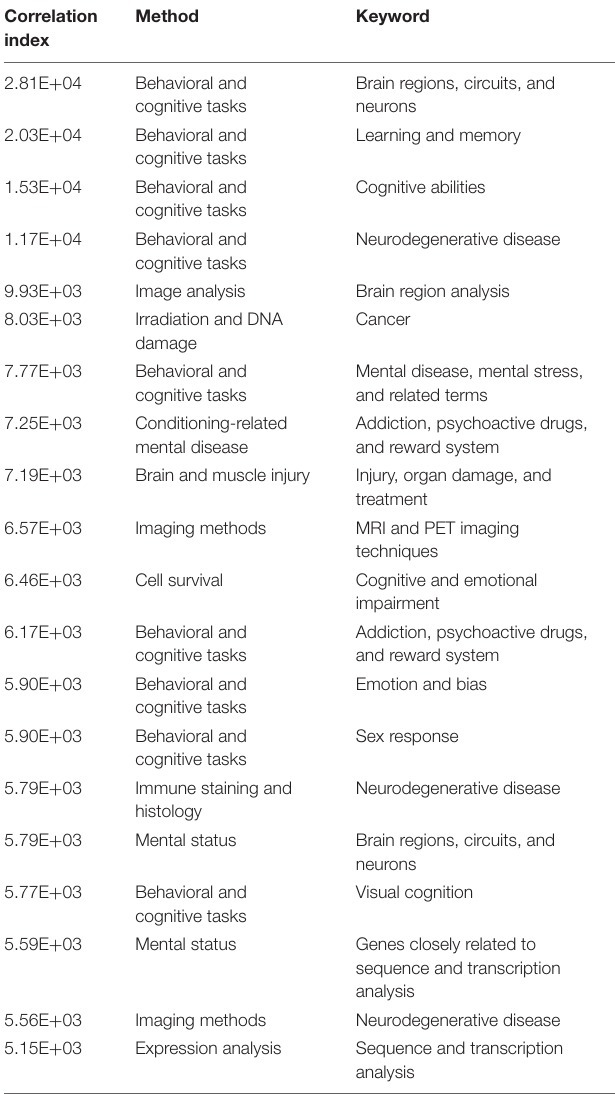
TABLE 1 | Twenty most common combinations of the clusters of methods and